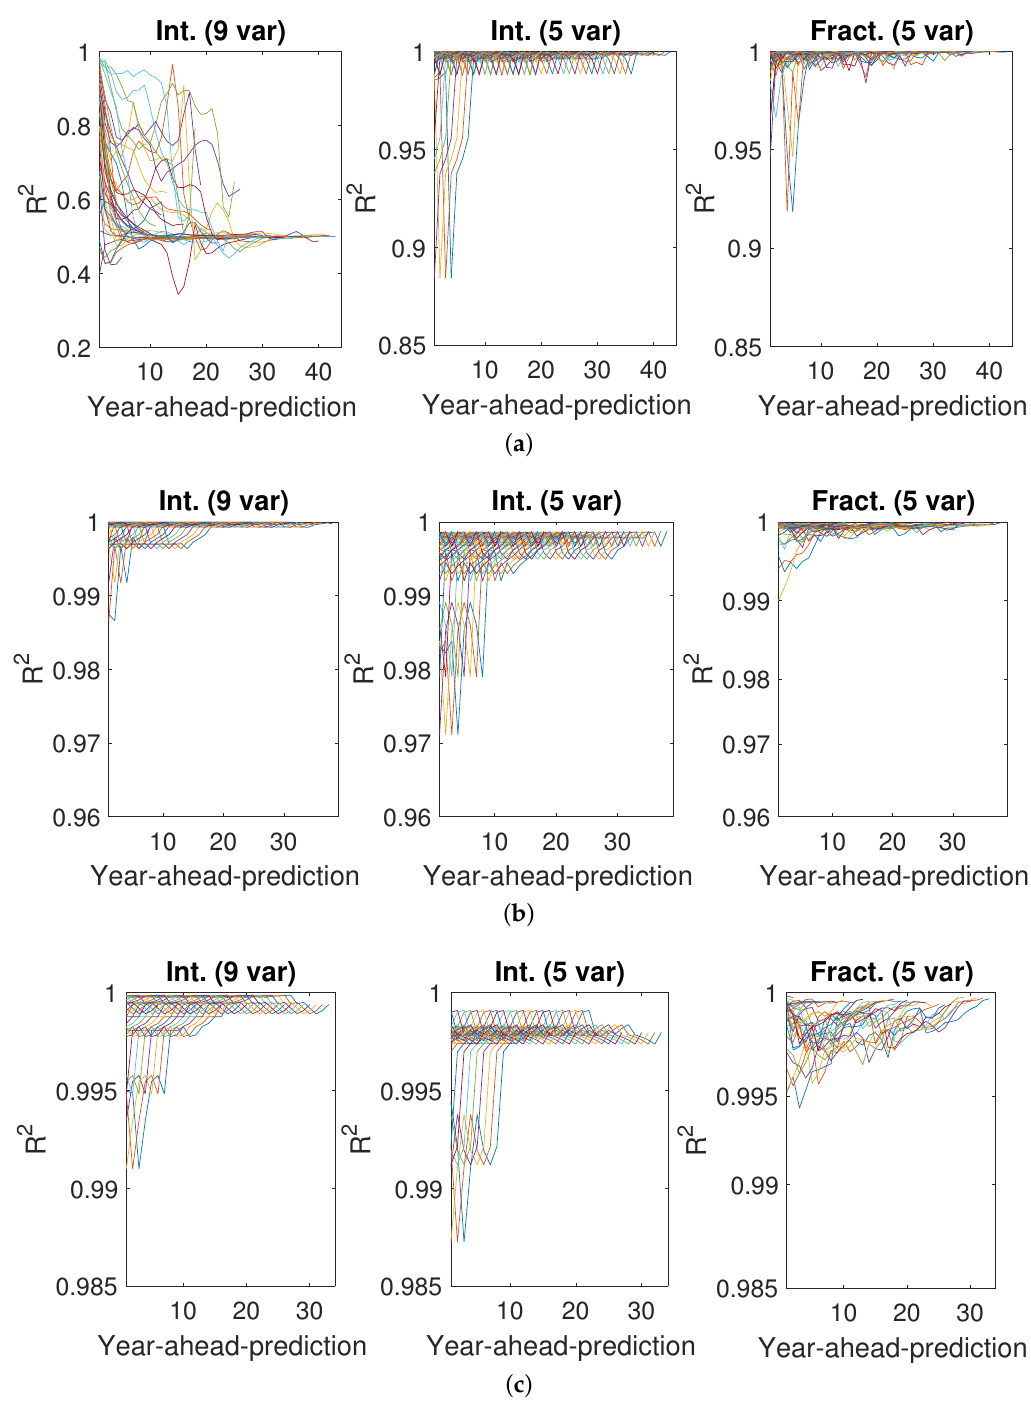
Figure 7. R 2 values of GDP estimates for India. Estimates were obtained with models (1) (left), (2) (middle), and (3) (right). The models were obtained with data for different numbers of years: ( a ) N = 5 (top) ( b ) N = 10 (center) ( c ) N = 15 (bottom). The models were used to estimate the GDP for as many years as possible after the period for which they were built. The scale of the y -axis is not the same for all models and all values of N